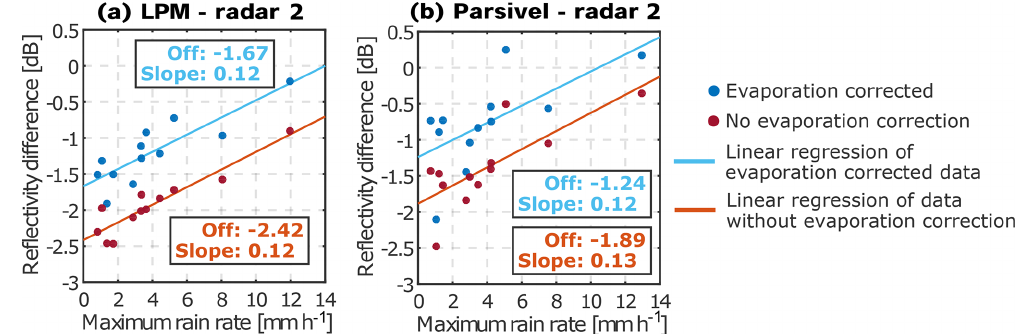
Figure 18. The results of the disdrometer-based method from 12 rain events. The calibration evaluation is made for radar 2 using LPM (a) and Parsivel (b) . Each dot represents a result for a single rain event. Solid lines show linear regressions. Offsets and slopes of the regressions are given in the corresponding boxes. The colors of the dots and lines indicate whether the evaporation correction has been applied (blue) or not